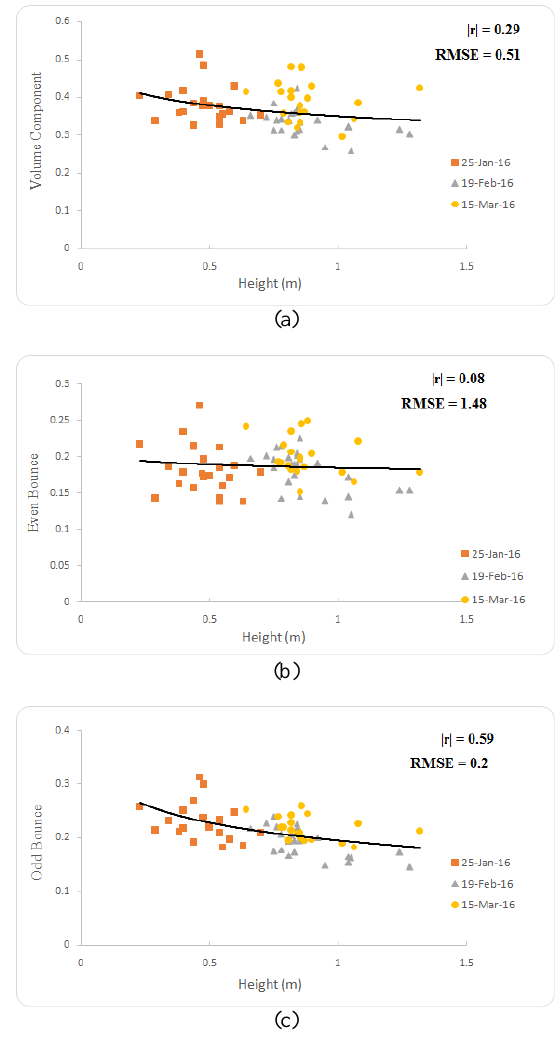
Figure 6. Scatterplot of Stokes parameters [(a): volume component; (b) even bounce; (c) odd bounce] vs wheat